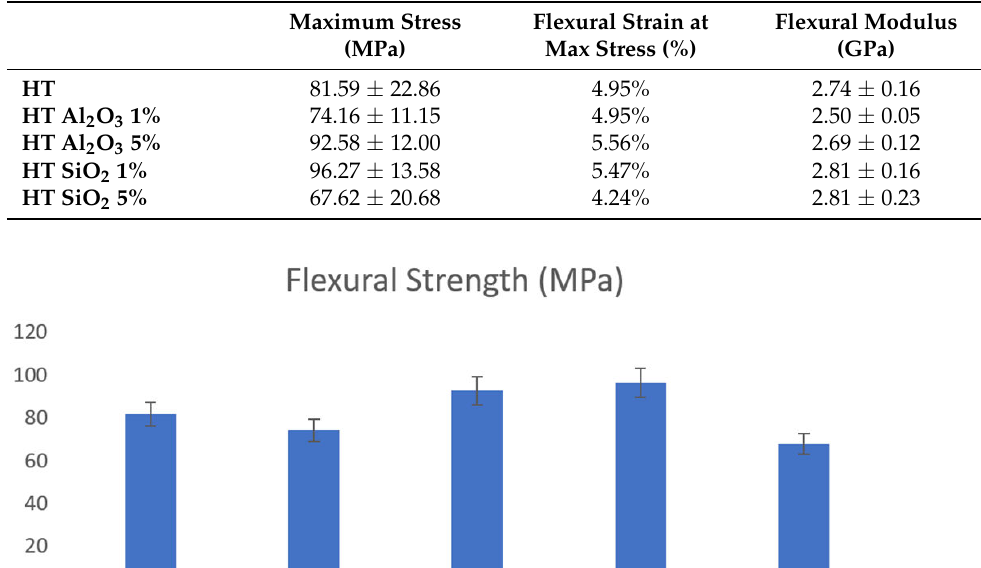
Table 5. Flexural test results.